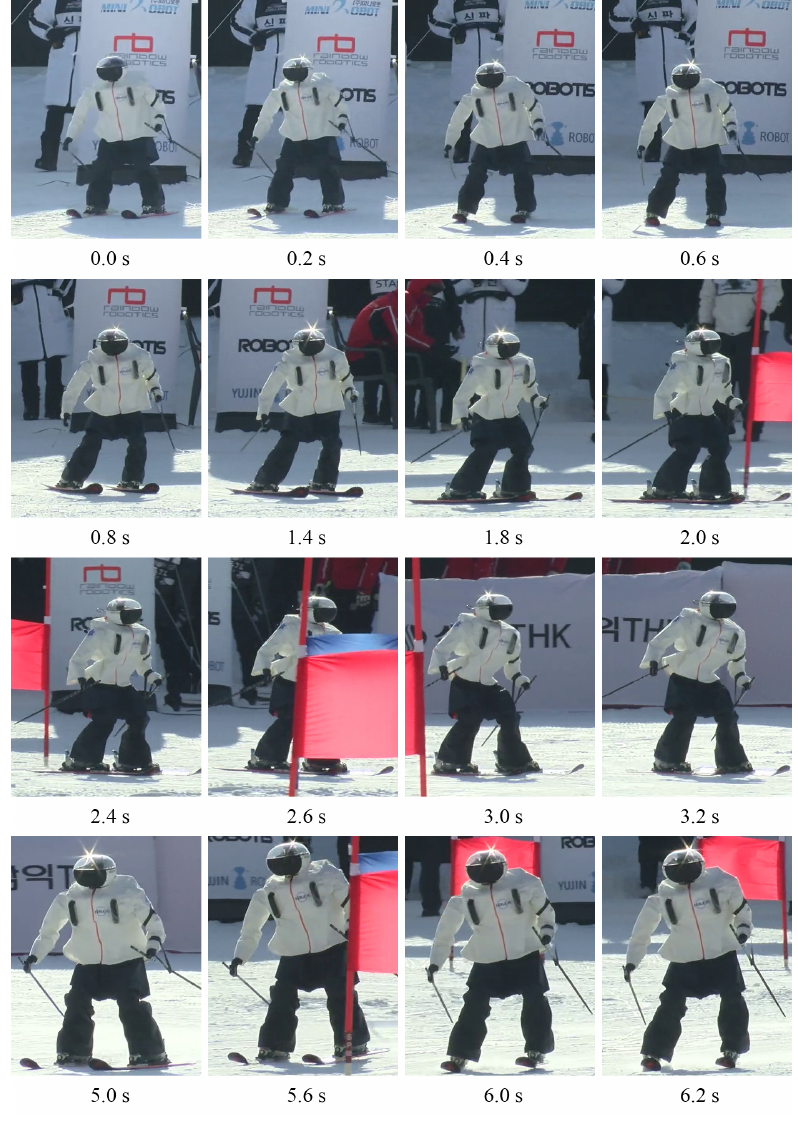
Figure 17. The scene wherein DIANA travelled down the slope.